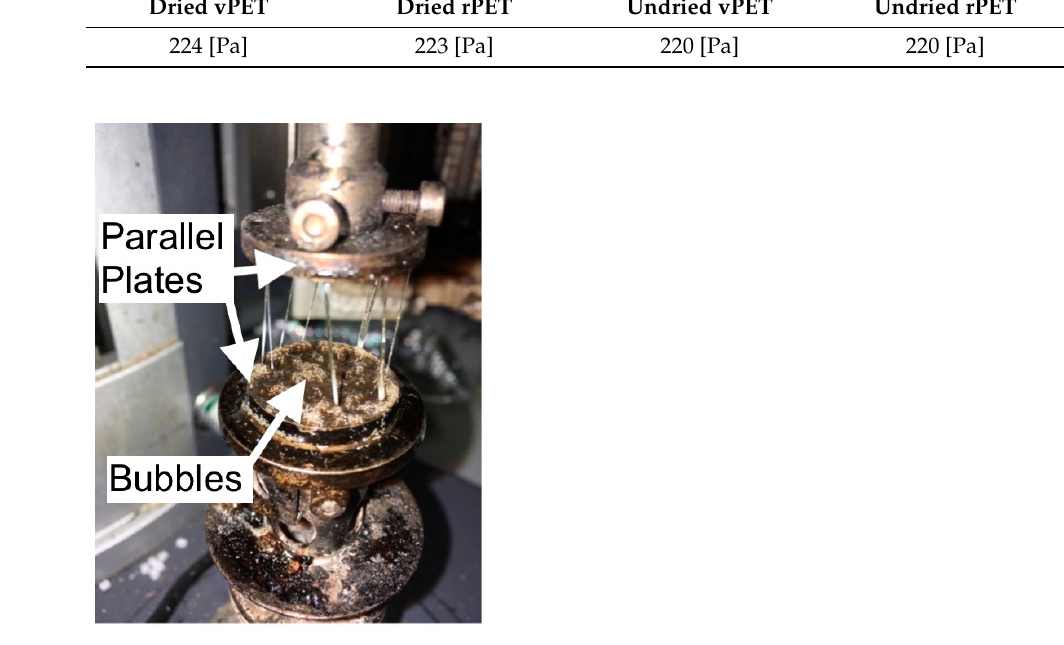
Figure 8. Degraded rPET after relaxation test.